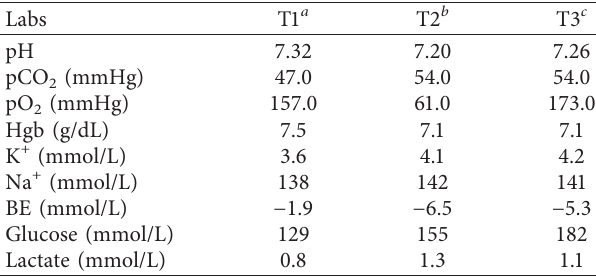
Table 1: Arterial blood gases from the third